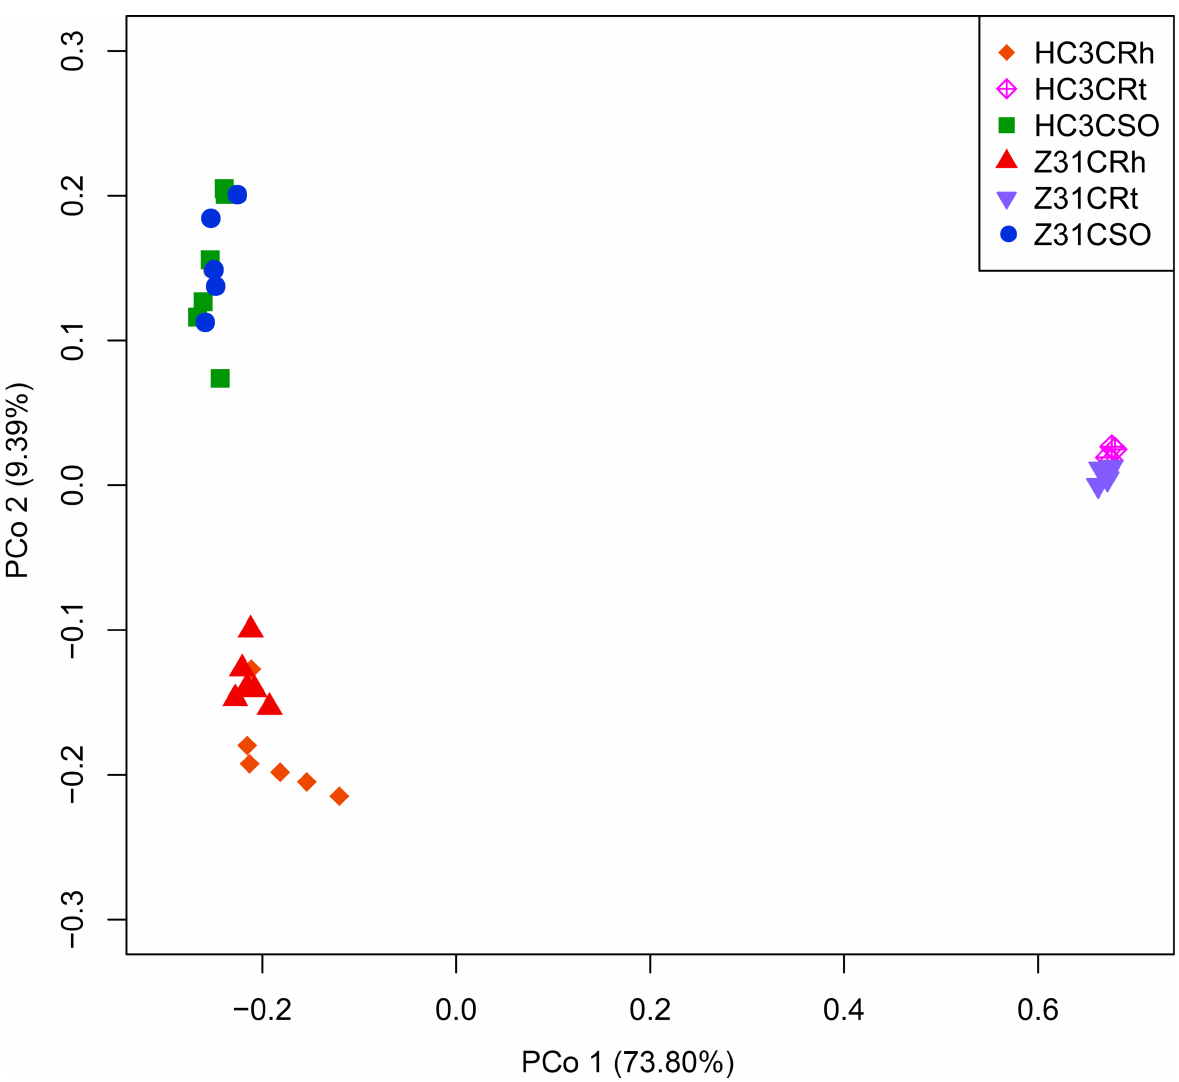
Fig 2. PCoA based on the Bray–Curtis distance metrics of root-associated bacterial communities between Z31 and HC3 at the flowering stage (n = 32). HC3CRt and Z31CRt represent the roots of the recipient cultivar HC3 and the transgenic line Z31 at the flowering stage, respectively. HC3CRh and Z31CRh represent the rhizospheric soils of the recipient cultivar HC3 and the transgenic line Z31 at the flowering stage, respectively. HC3CSO and Z31CSO represent the surrounding soils of the recipient cultivar HC3 and the transgenic line Z31 at the flowering stage, respectively.